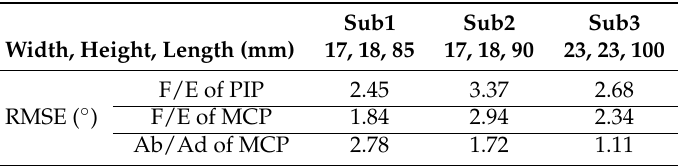
Table 3. Index finger experiments by various subjects. The width and height were measured as the length of the proximal phalanx in the transverse and sagittal planes, respectively. The length of the finger was measured from the MCP joint to the fingertip of the index finger.